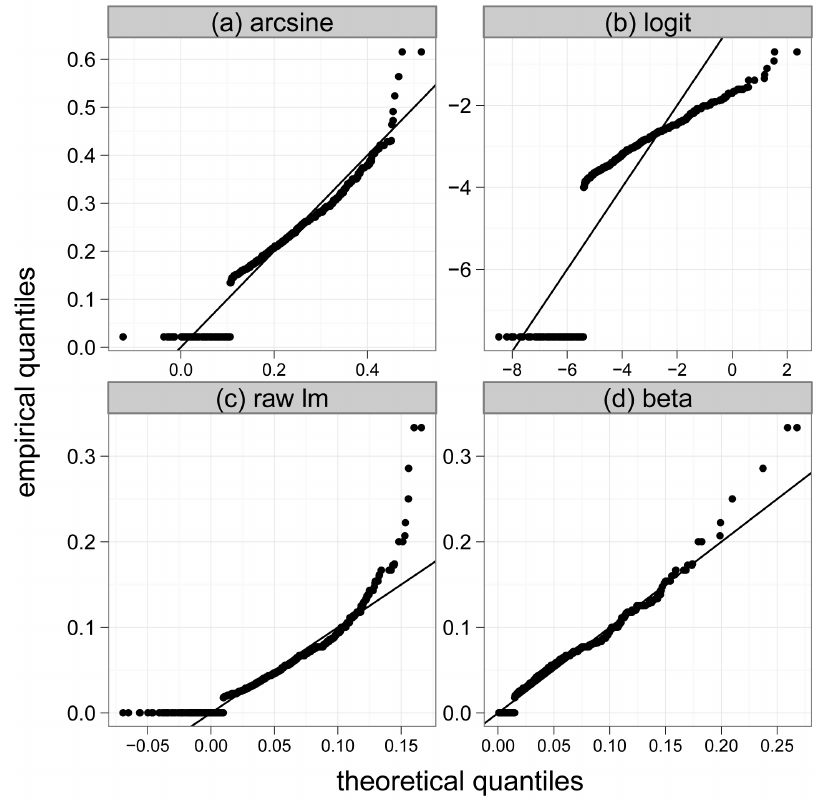
Figure 3. Normal quantile-quantile plots. Normal quantile-quantile plots of arcsine-square-root-transformed (‘‘arcsine’’), logit-transformed (‘‘logit’’) and untransformed (‘‘raw lm’’) EPHEptax values (panels (a) - (c)). Panel (d) shows a beta quantile-quantile plot using the untransformed EPHEptax values. It is seen that EPHEptax is best approximated by a beta distributed random variable.